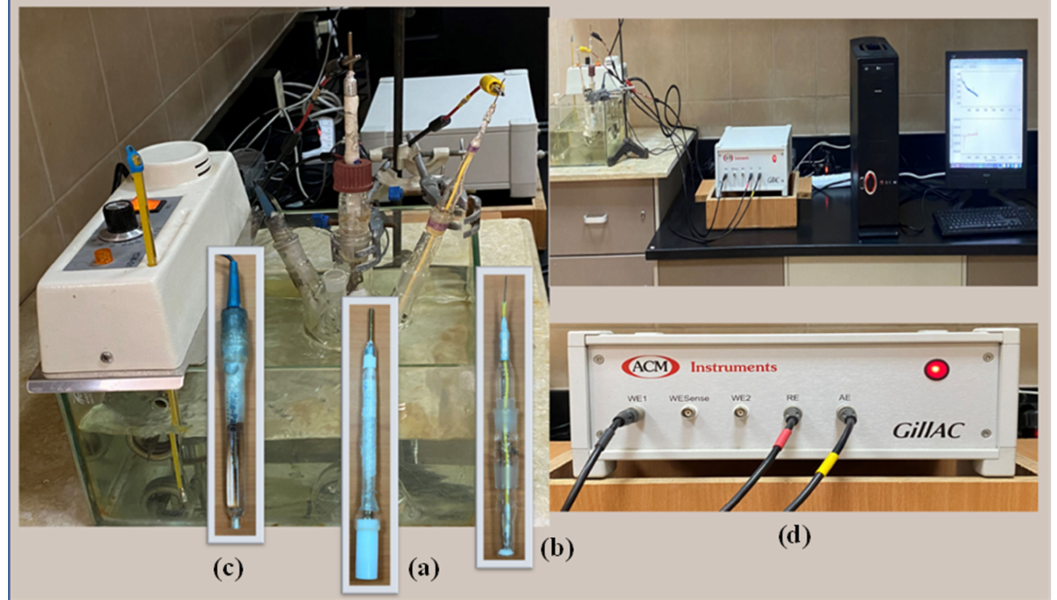
Figure 3. System used for electrochemical measurements. ( a ) Working electrode, ( b ) Counter electrode, ( c ) Reference electrode, ( d ) ACM